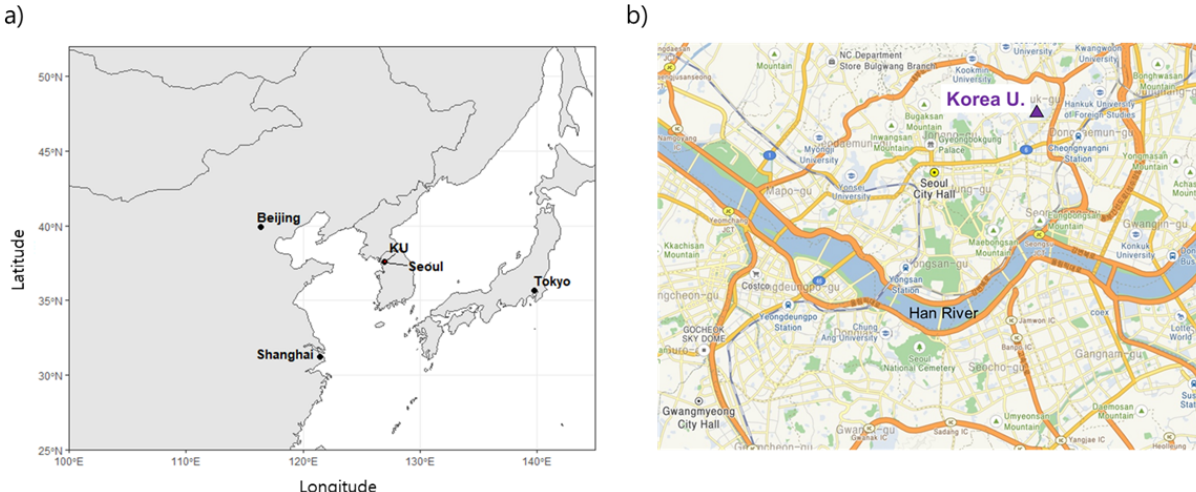
Figure 1. Location of the study region. (a) Seoul metropolitan area in South Korea; the map was generated using the open-source software R (http://www.R-project.org/, last access: 2 February 2021). (b) Sampling site of the Korea University campus in the northeast Seoul; the map was taken from © Kakao maps (https://map.kakao.com/, last access: 29 December 2021).